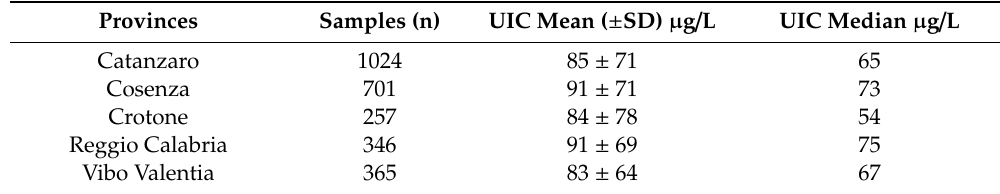
Table 1. Mean ( ± DS) and median urinary iodine concentration (UIC) in schoolchildren in the Calabria